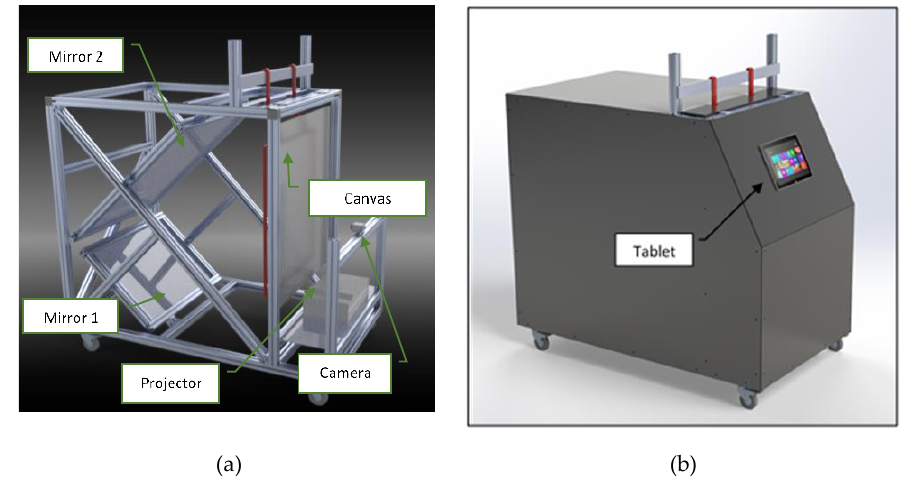
Figure 14. ( a ) Counting machine architecture; ( b ) final design of the counting machine.